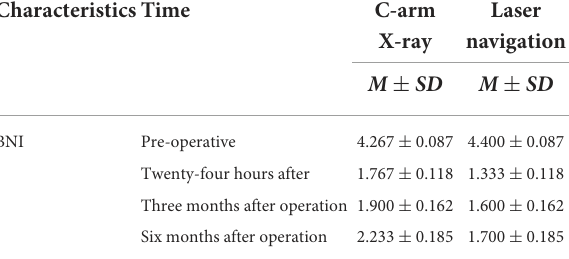
TABLE 3 The BNI score of C-arm X-ray group and Laser navigation group. Characteristics